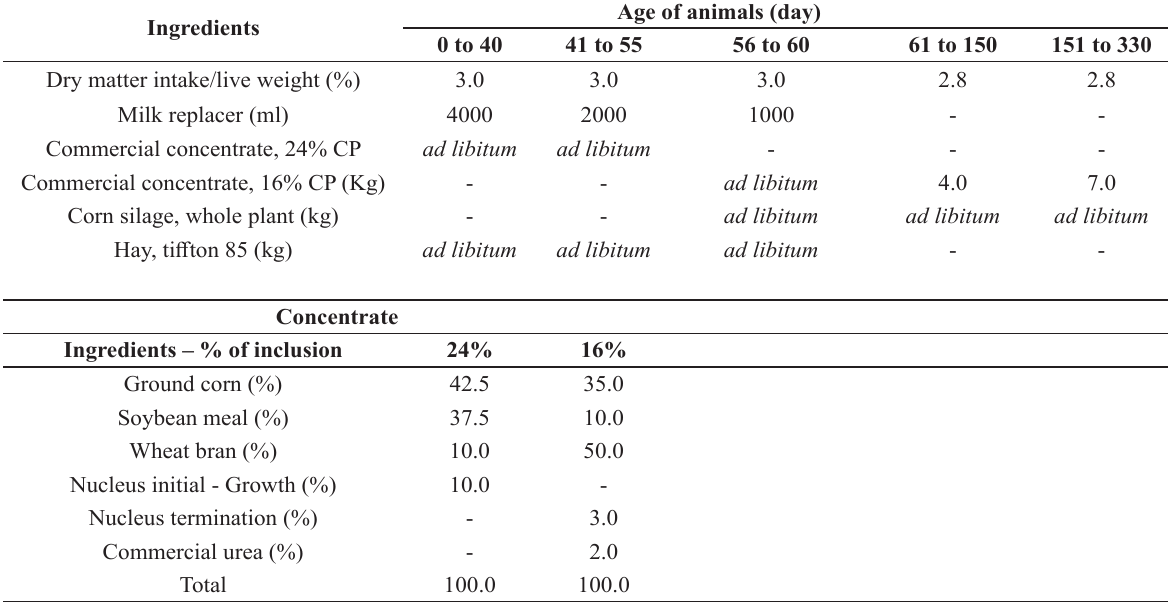
Diet provided to animals from birth to